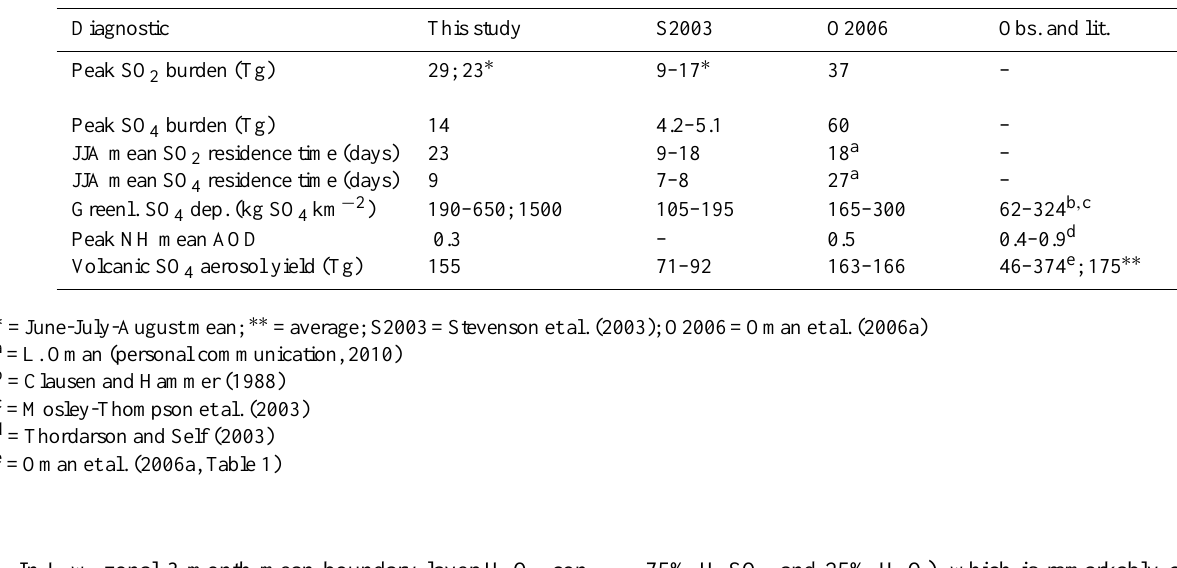
Table 1. Comparison with previous modelling studies and literature-based